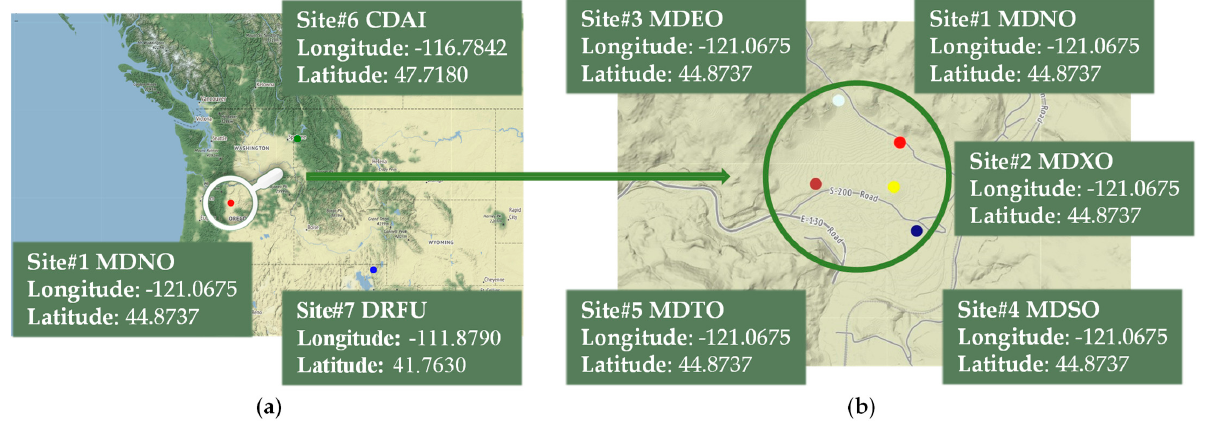
Figure 5. Seven selected wind farms with their longitudes and latitudes: ( a ) nonadjacent wind farms from Site 1 to Site 6 to Site 7; ( b ) adjacent wind farms from Site 1 to Site 5. Four indices, the root mean squared error (RMSE), mean absolute error (MAE), mean absolute percentage error (MAPE) and R-squared (R 2 ), are used for evaluation [28,35].